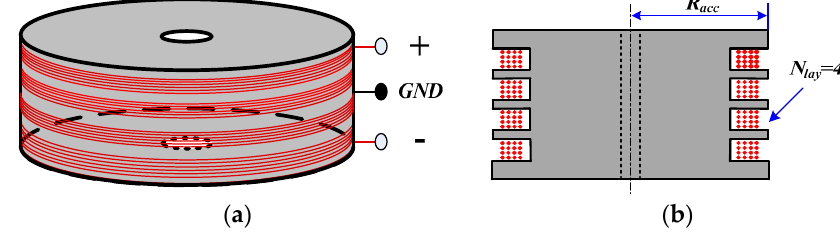
Figure 3. ( a ) An air-core coil with a differential structure; and ( b ) its typical design ( R acc —radius of the air-core coil, N lay —number of layers).